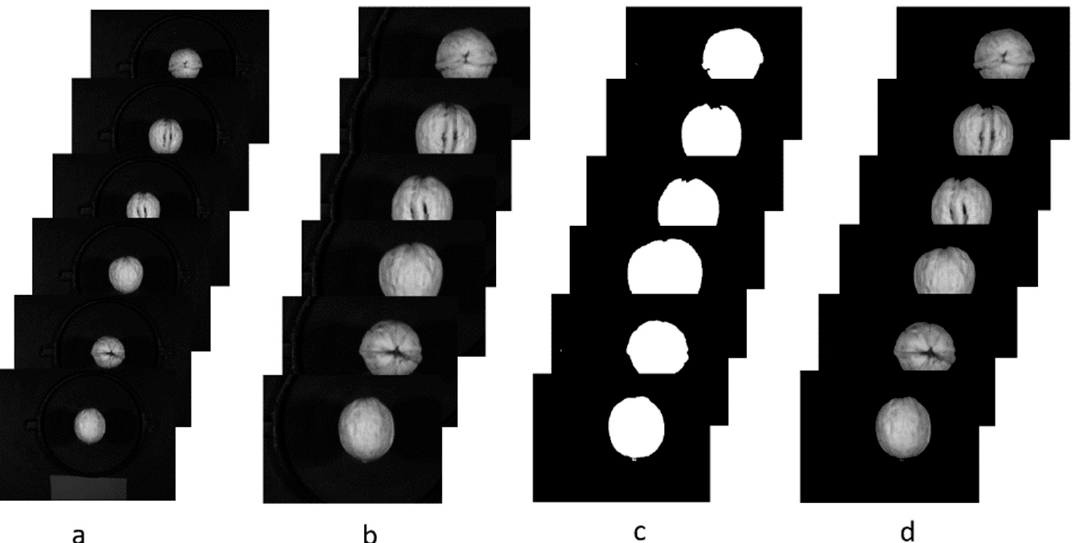
Figure 8. Process flow for extracting reflected spectra: ( a ) the original images, ( b ) cropping, ( c ) thresh-